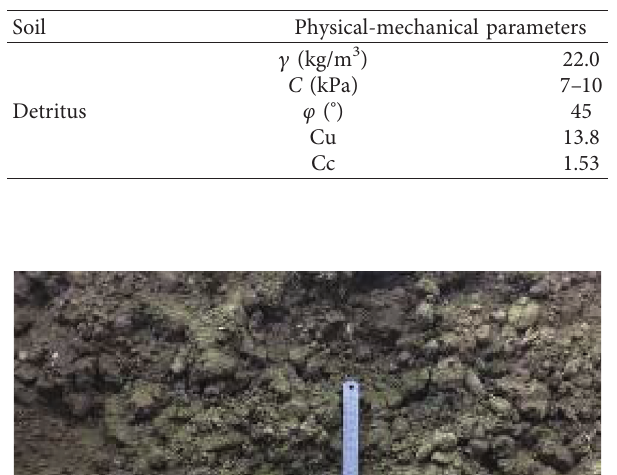
Table 2: Parameters of model